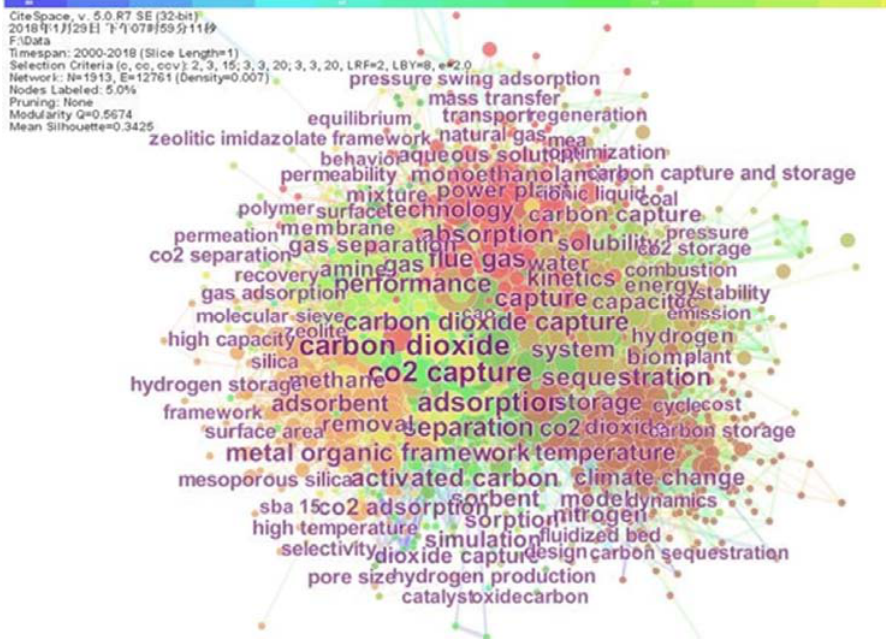
Figure 5. Co ‐ occurring keyword network of CCS research area. Figure 5. Co-occurring keyword network of CCS research